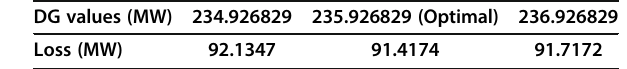
Table 23 Comparison of power loss at the IEEE 118 bus system with different DG power placed at bus no. 40 using the JAYA